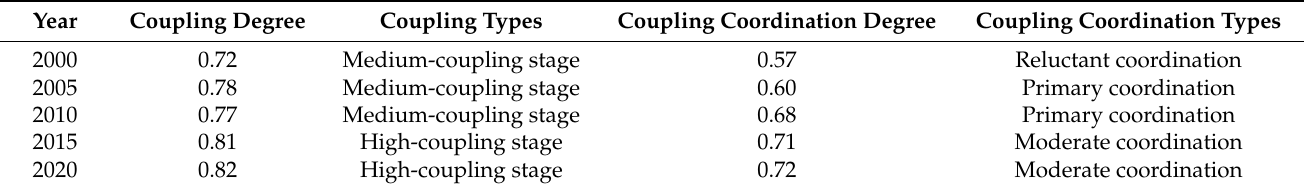
Table 9. The overall coupling degree and coupling coordination degree between residents’ livelihood and land ecosystem service value in the ORTTR from 2000 to